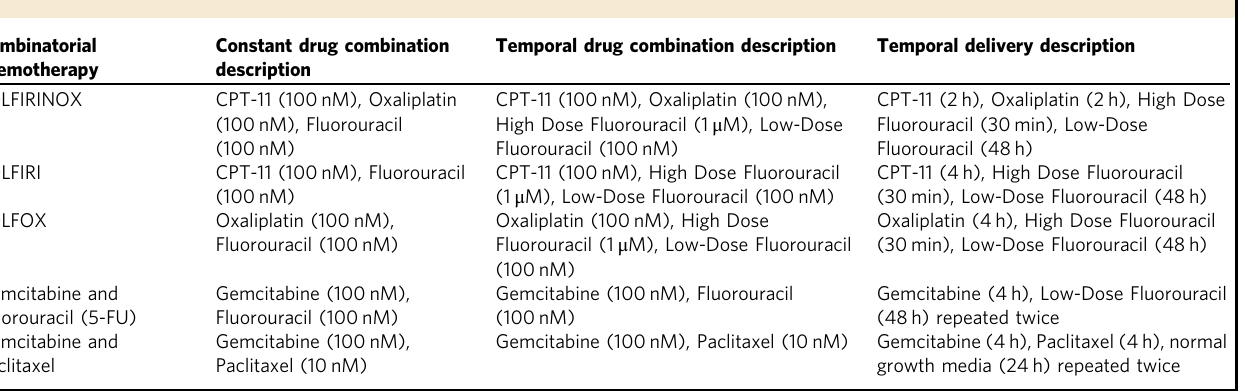
Table 1 Temporal drug